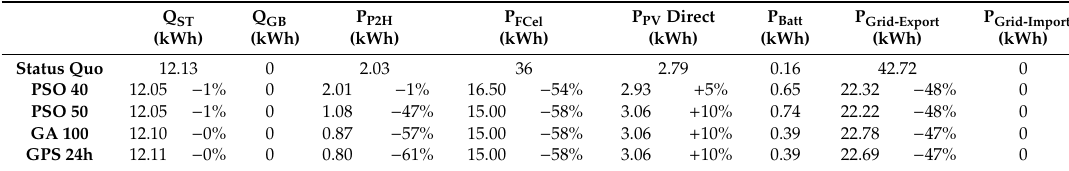
Figure 15. Manipulated variables of the optimized fitness of each algorithm plotted with the initial iteration and the status quo on the summer day. Table 5. Key energy values from the best point of each optimized control on the summer